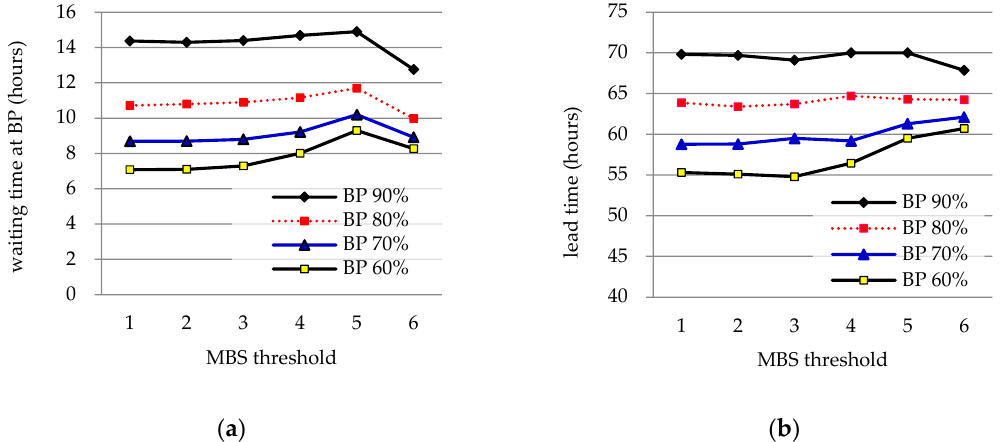
Figure 8. Performance of different MBS levels batch sizes in the MBS control in terms of ( a ) waiting time at BP station and ( b ) system lead time.